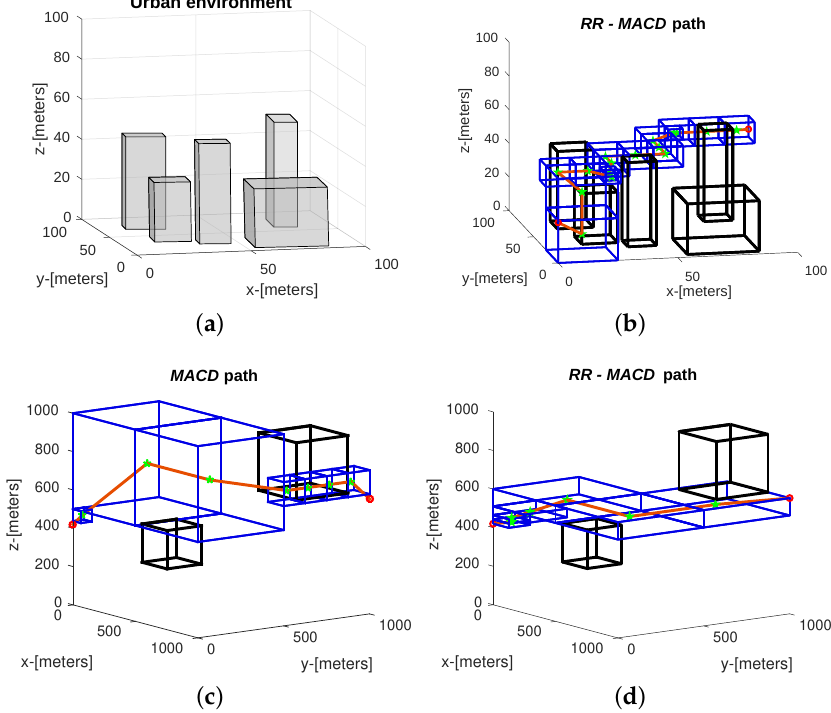
Figure 10. Graphical Results of Example 1. ( a ) Modeled urban environment cluttered with surrounding buildings. ( b ) Results for environment #1 with RR-MACD . ( c ) Final path generated using MACD for environment #2. ( d ) Final path generated using RR-MACD for environment